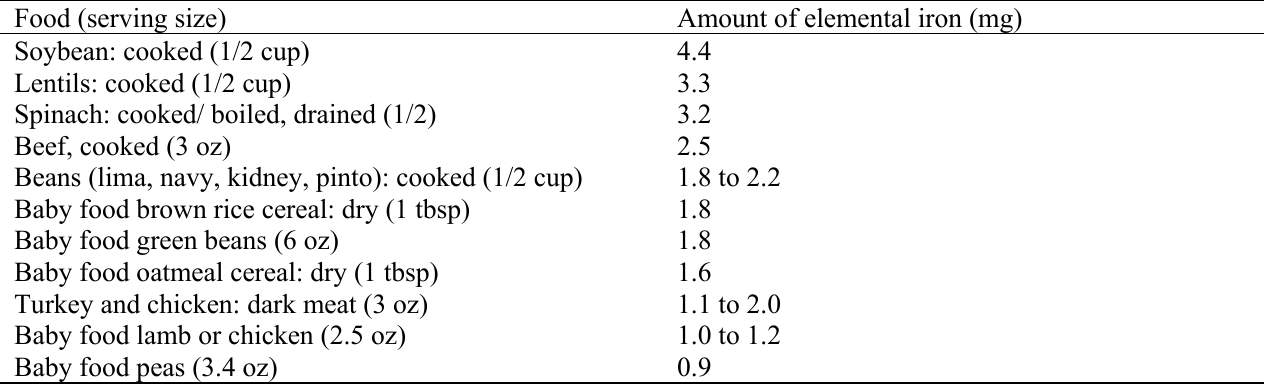
Table 3. Iron content in common foods